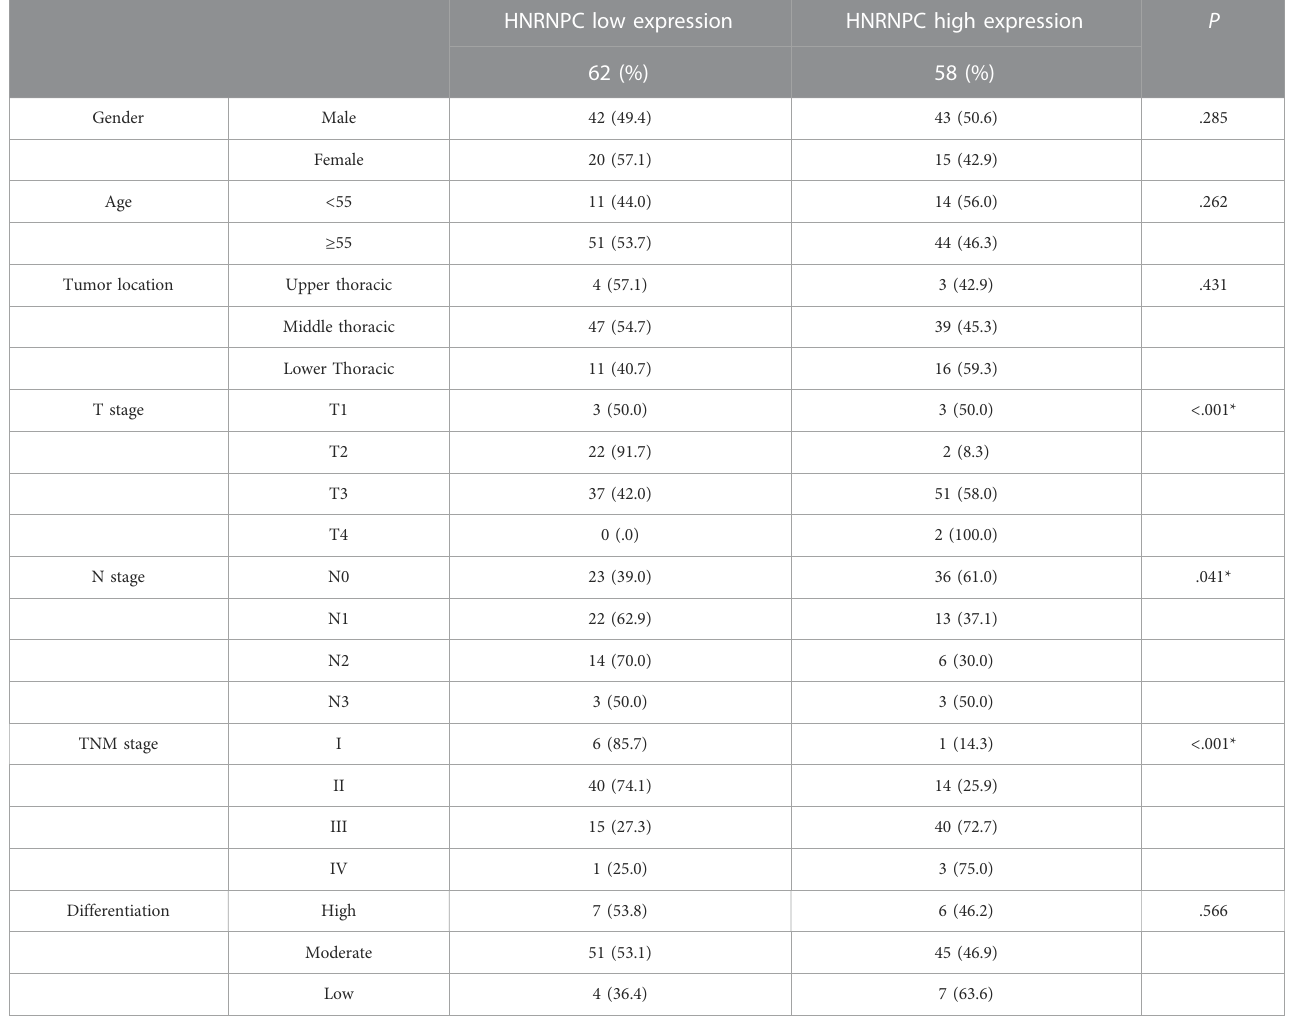
TABLE 2 Clinicopathological characteristics of HNRNPC expression on ESCC tissue sections.